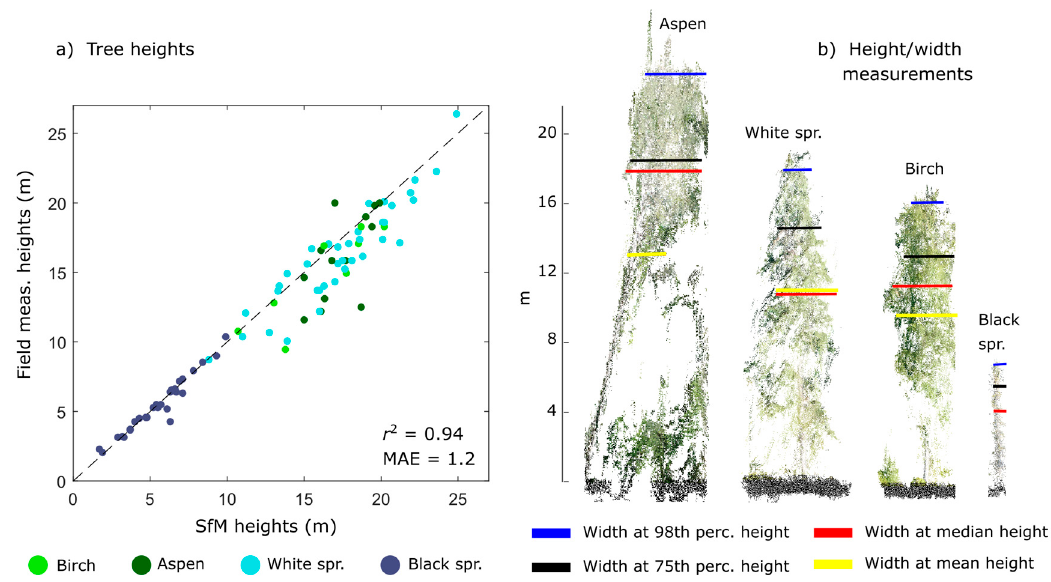
Figure 3. Structural parameters for individual trees were extracted from the SfM point cloud using segmentation. ( a ) Max crown height from SfM compared to field measurements; ( b ) an example of width at percentile height calculations for each focus species.